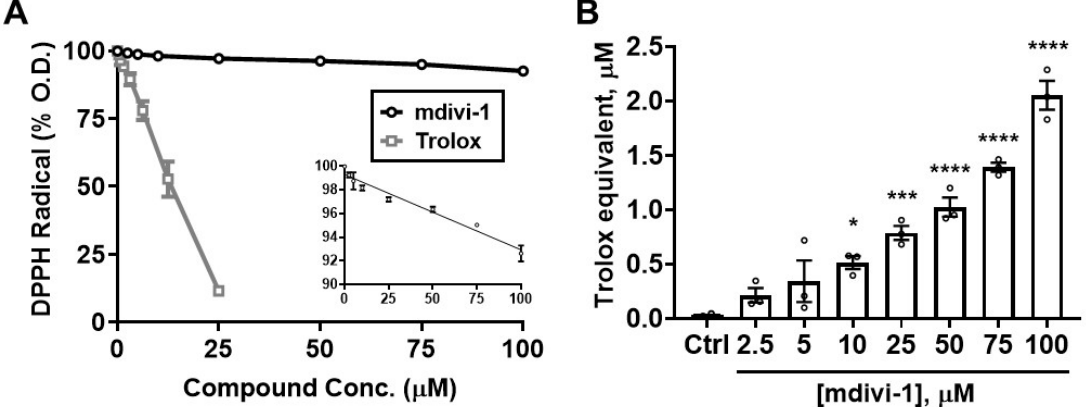
Figure 3. Mdivi-1 weakly but dose-dependently depletes DPPH radical. ( A ) Mdivi-1 (2.5–100 µ M) or Trolox (0.78–25 µ M) was added to DPPH radical and antioxidant activity was monitored by the DPPH decolorization assay as a decrease in optical density (O.D.), expressed as a percentage of the initial O.D. Each value is depicted as the mean ± SEM from n = 3 separate experiments. The inset in ( A ) shows the means ± SEM for the mdivi-1 group on a compressed scale (DPPH Radical (% O.D.), y-axis vs. Compound Conc. ( μ M), x-axis), fit by linear regression analysis (R 2 = 0.9139, p < 0.001). ( B ) Trolox-equivalent antioxidant capacity (TEAC) of mdivi-1 for the depletion of DPPH. Bar graphs represent means ± SEM from n = 3 separate experiments. One-way ANOVA, F-value (7, 16) = 48.44, p < 0.0001, was followed by Bonferroni’s multiple comparisons post hoc test comparing mdivi-1 treatment to Ctrl. * p < 0.05, *** p < 0.001, **** p <